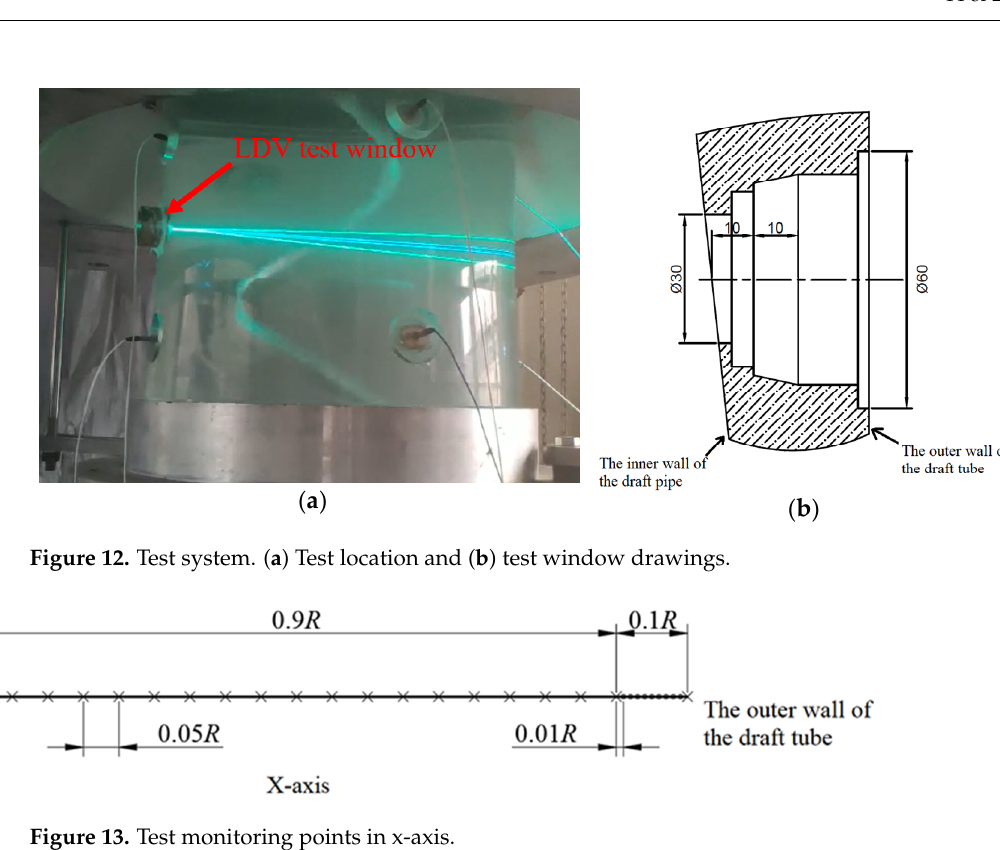
Table 5. Test operating points. Figure 13. Test monitoring points in x-axis.